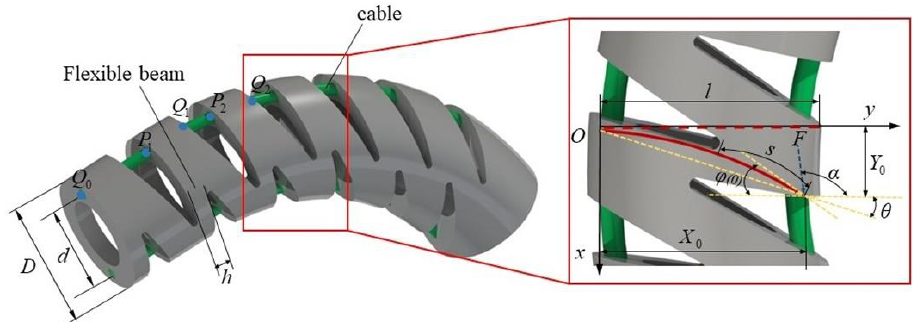
Figure 5. Analysis diagram of the equivalent beam loaded with an external concentrated load ( F ) at the end of the beam.